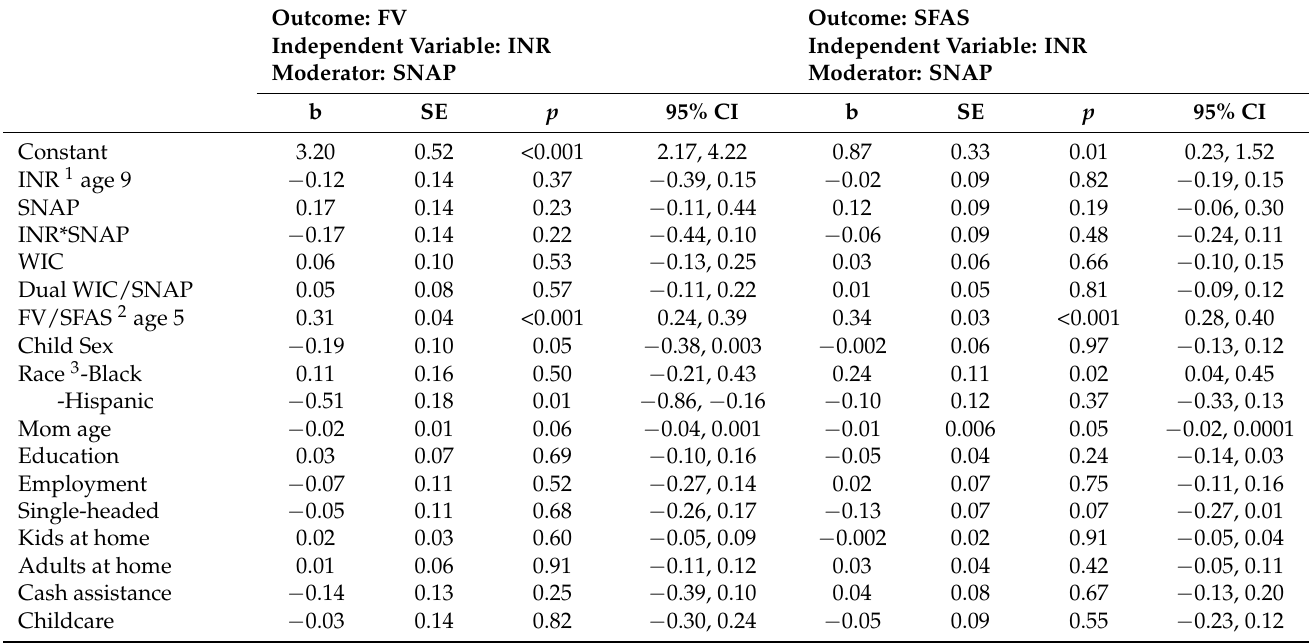
Table 3. Accumulation of SNAP on Change in FV and SFAS Intake from Ages 5 to 9 Years ( n =